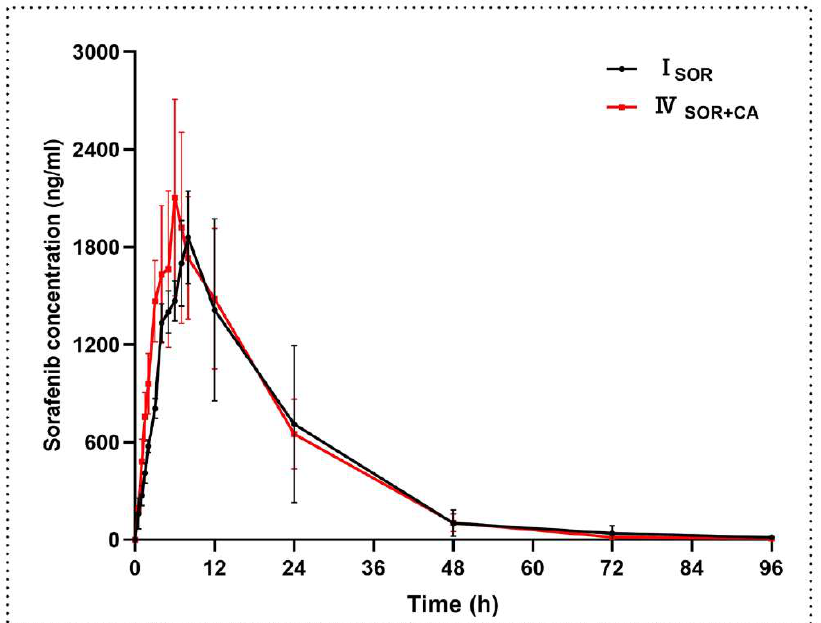
Figure 3. The mean plasma concentration–time curves of sorafenib after administration. Each data point represents the mean ± standard deviation (n = 6). I SOR , sorafenib (100 mg/kg); IV SOR+CA , sorafenib (100 mg/kg) oral co-administered with canagliflozin (10 mg/kg). Table 4. Pharmacokinetic parameters of sorafenib in rat plasma after oral administration of single dose sorafenib (100 mg/kg) and combined with canagliflozin (10 mg/kg); n = 6 for each group. Parameters